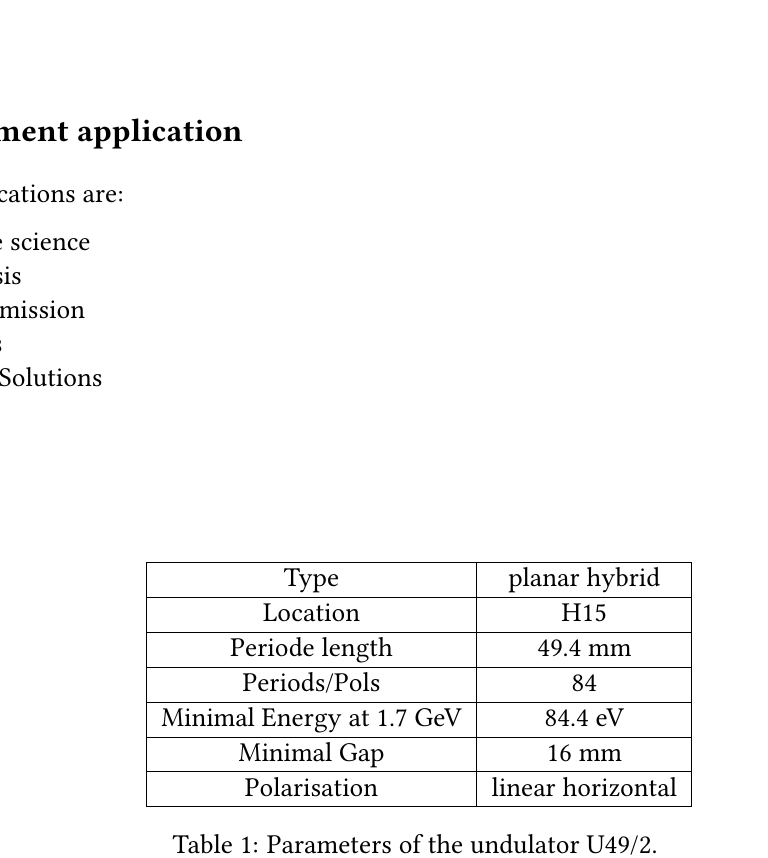
Figure 1: Top-view of beamline U49/2 PGM1.